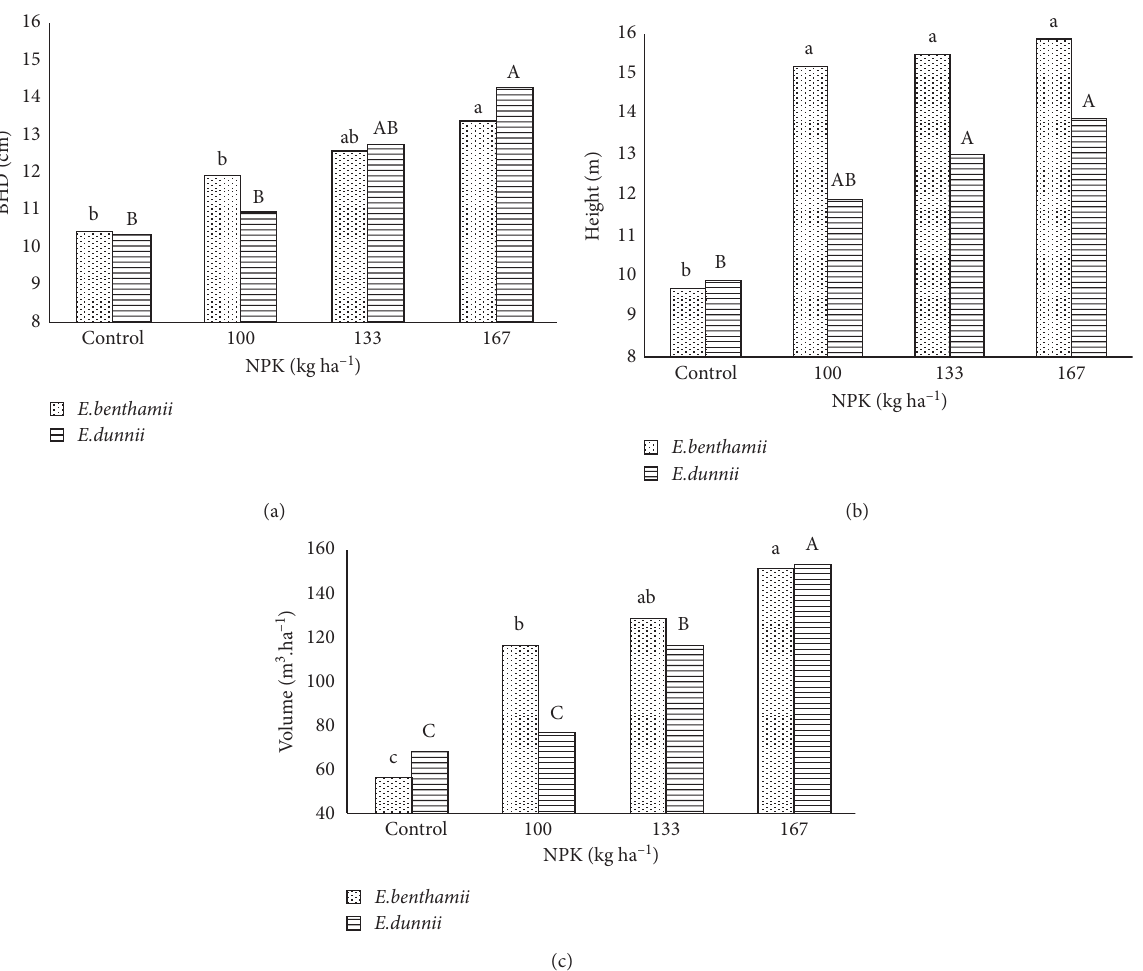
Figure 1: (a) Breast height diameter (BHD, cm), (b) height (m), and (c) volume (m3 ha − 1 ) in Eucalyptus benthamii and Eucalyptus dunnii in relation to NPK fertilizing. Averages followed by the same letter, lower and uppercase, do not differ between them by the Tukey test at 5% probability. Lowercase letters compare fertilization in relation to E. benthamii . Uppercase letters compare fertilization in relation to E. dunnii